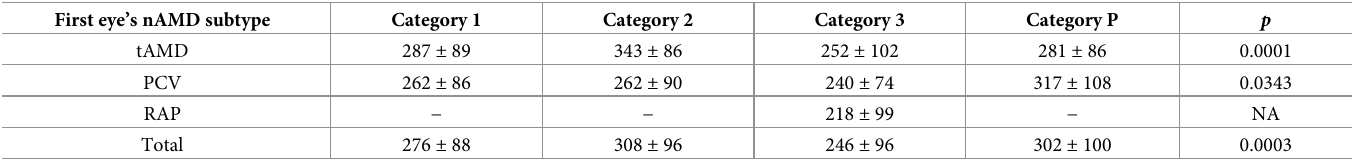
Table 2. SFCT in each category according to the first eye’s AMD